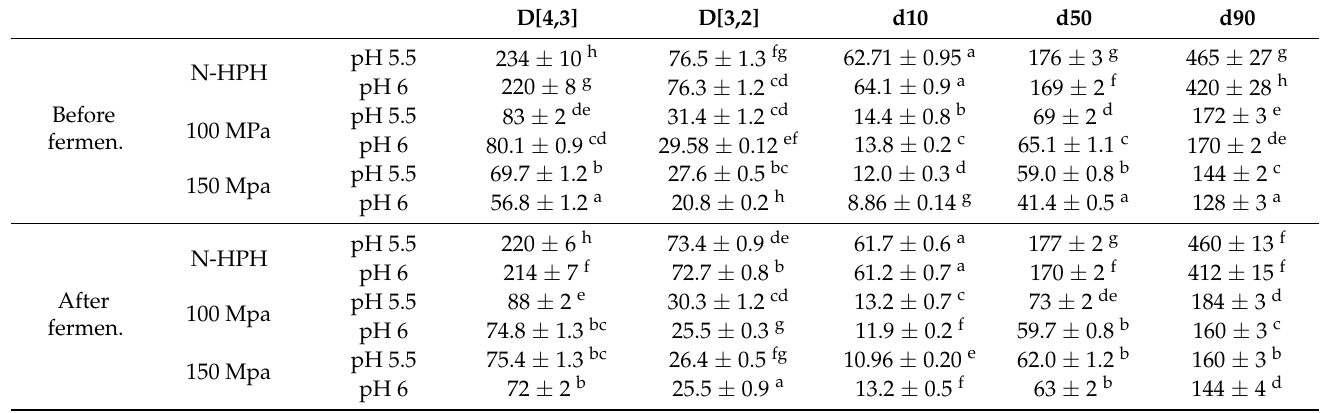
Table 2. Main parameters of particle size, before and after fermentation, of lulo juices at pH 5.5 and 6, non-homogenized and homogenized at 100 MPa and 150 MPa. D[4,3]: volume-weighed mean diameter; D[3,2]: surface based mean diameter; d10, d50, and d90: characteristic diameters below which 10%, 50%, and 90% of the particles are included in the distribution. Mean values ± standard deviation.